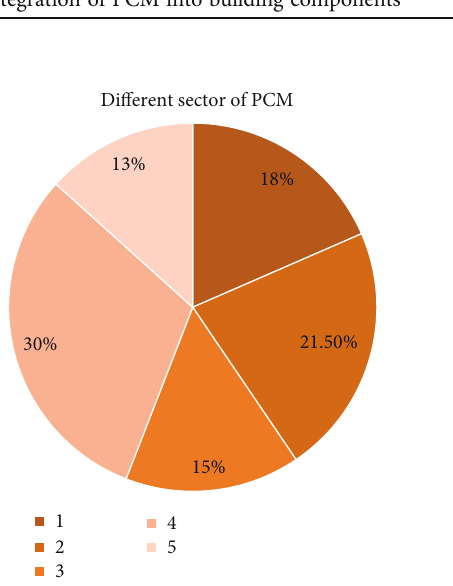
Figure 6: Comparison of PCM dealing in di ff erent sectors.